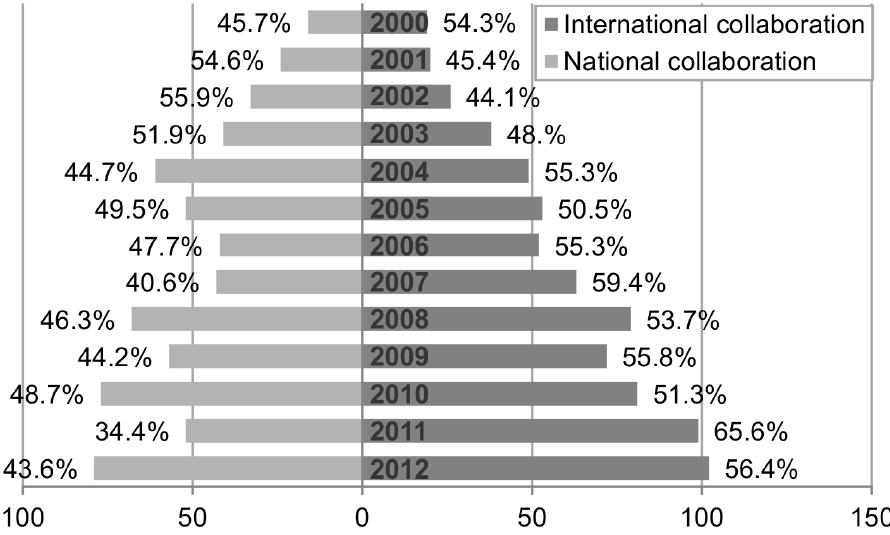
Figure 2. National versus international articles in Brazilian scientific output in Evolutionary Biology.